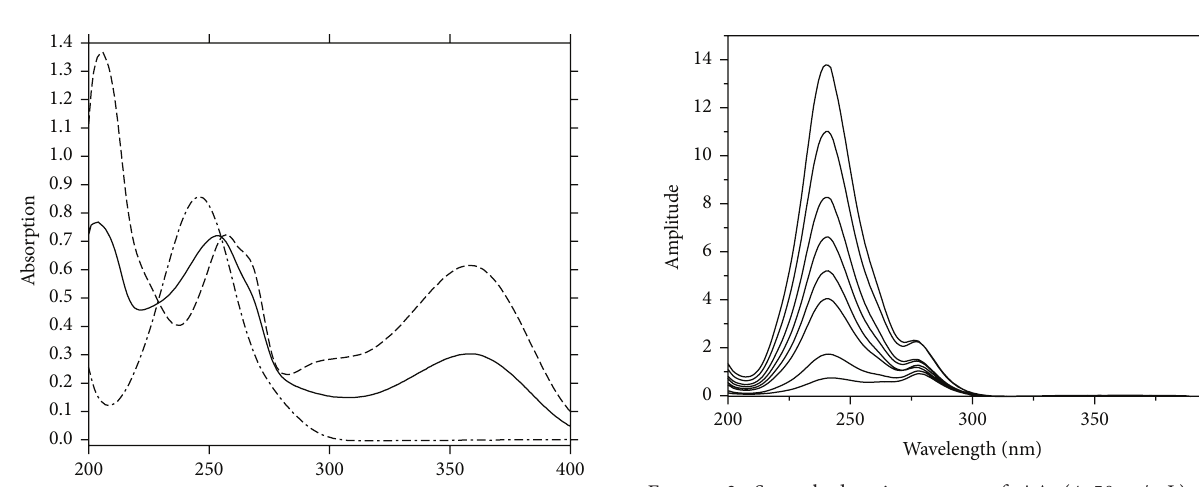
Figure 3: Smoothed ratio spectra of AA (4–50 𝜇 g/mL) using 8 𝜇 g/mL of RU as divisor and methanol as blank.